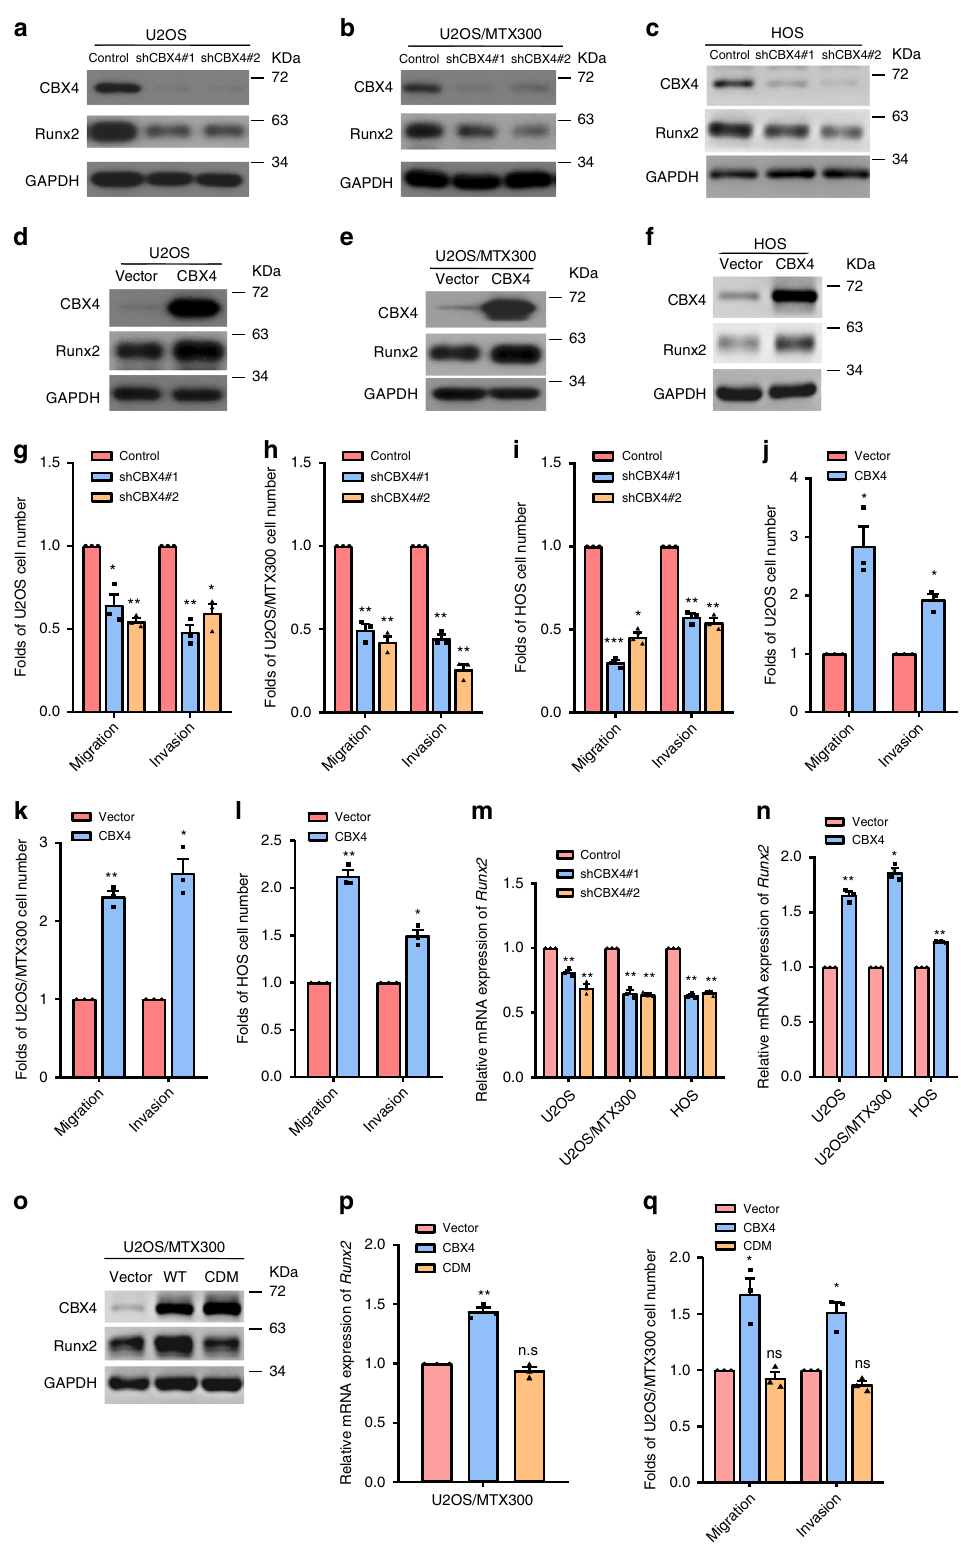
Fig. 1 CBX4 promotes cell migration and invasion by increasing Runx2 in osteosarcoma cells. a – f , o The indicated proteins were analyzed by Western blotting in the indicated stable cells of three independent experiments. g – l , q Migration and invasion abilities were determined using the indicated stable cells as described in Methods section. m , n , p The relative mRNA levels of Runx2 were normalized to the GAPDH level in the indicated stable cells as determined by qRT-PCR. The bars indicate the SD. The results are expressed as the mean ± SD of three independent experiments. * p < 0.05, ** p < 0.01, *** p < 0.001 using the two-sided Student ’ s t -test. n.s, no signi fi cance. Source data are provided as a Source Data fi